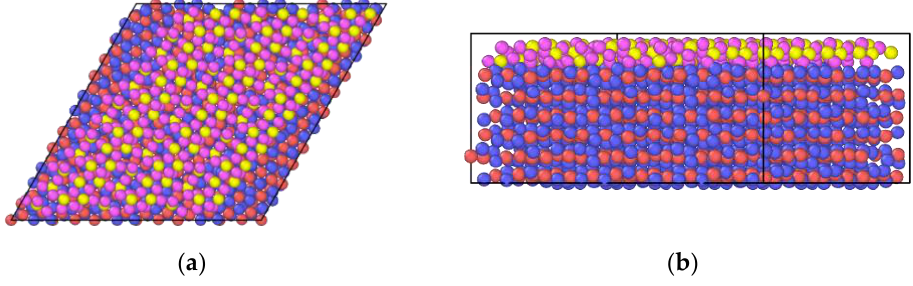
Figure 2. ZrO 2 (211) monolayer over In 2 O 3 (111): ( a ) top view, ( b ) front view.